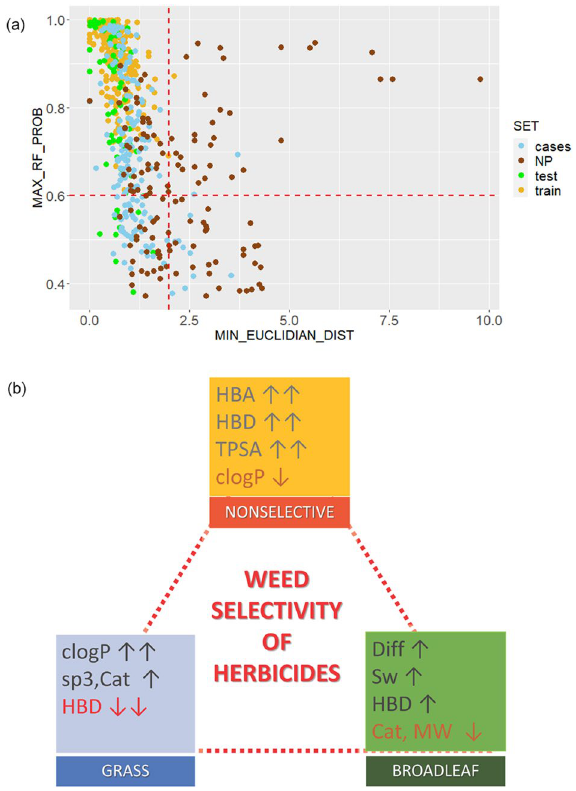
Figure 4. ( a ) The AD for the RF weed selectivity model ( 1 in Tables 3 and S6). Given a compound, the prediction can be considered credible for the class probability above 0.6 and the Euclidian distance less